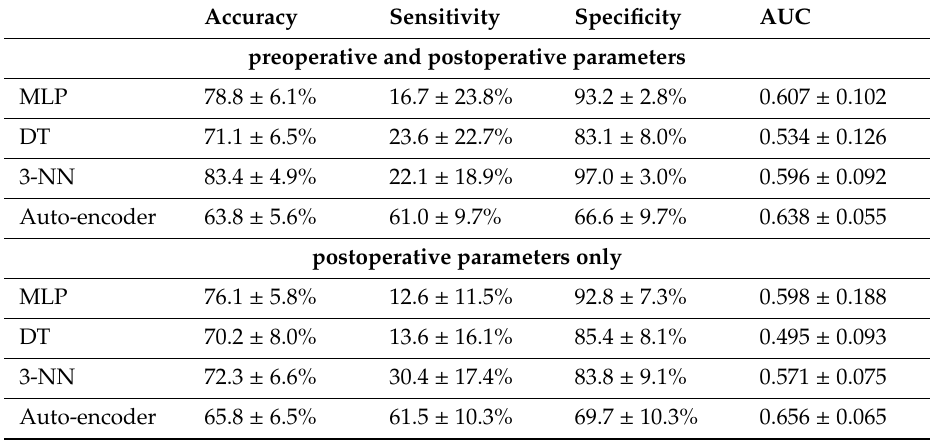
Table 2. Diagnostic performance of machine learning algorithms for the prediction of early biochemical recurrence.